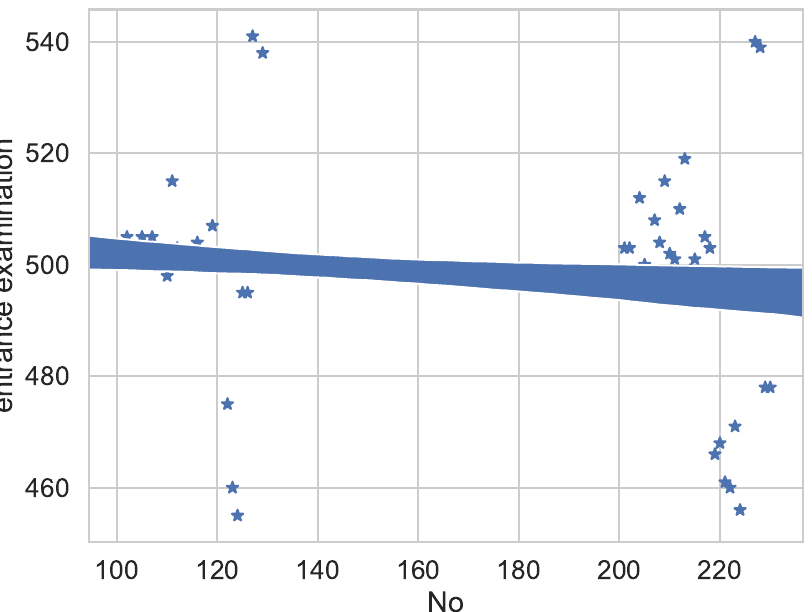
Figure 5. Student performance analysis entrance examination.